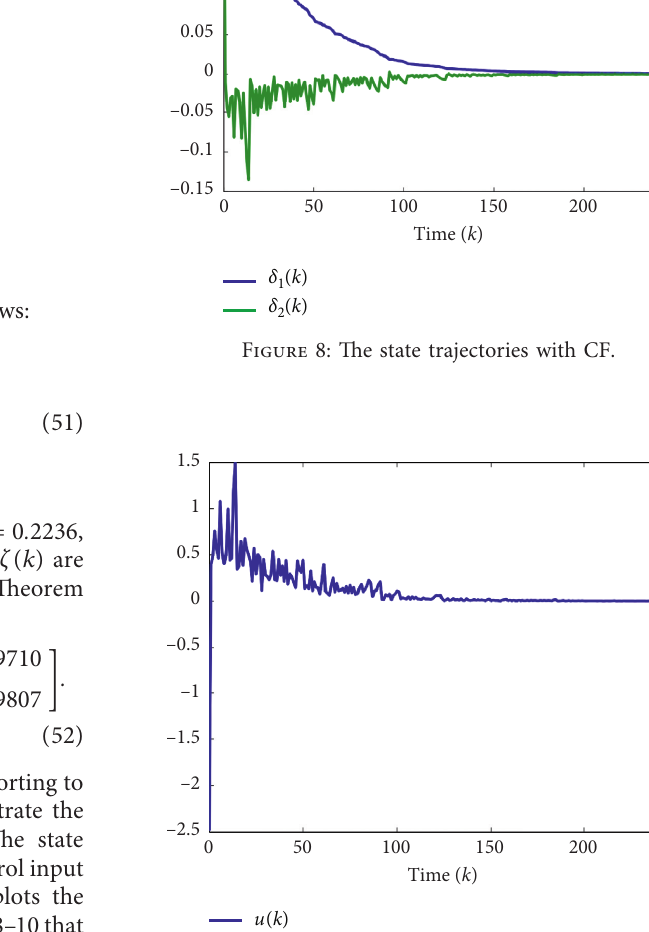
Figure 9: Control